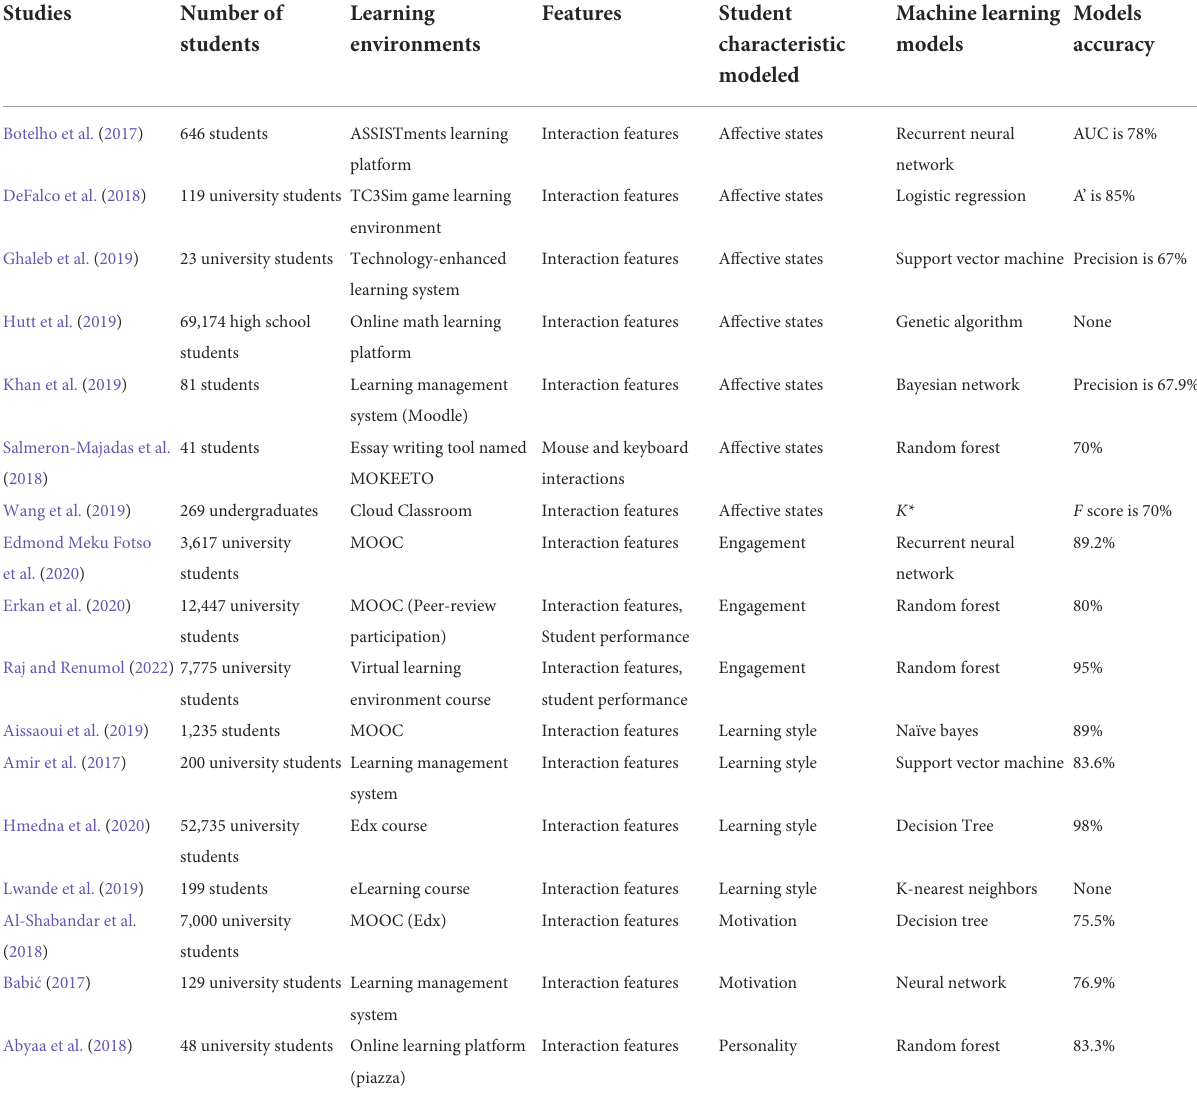
TABLE 1 Automatic modeling of student characteristics in learning studies using interaction-based